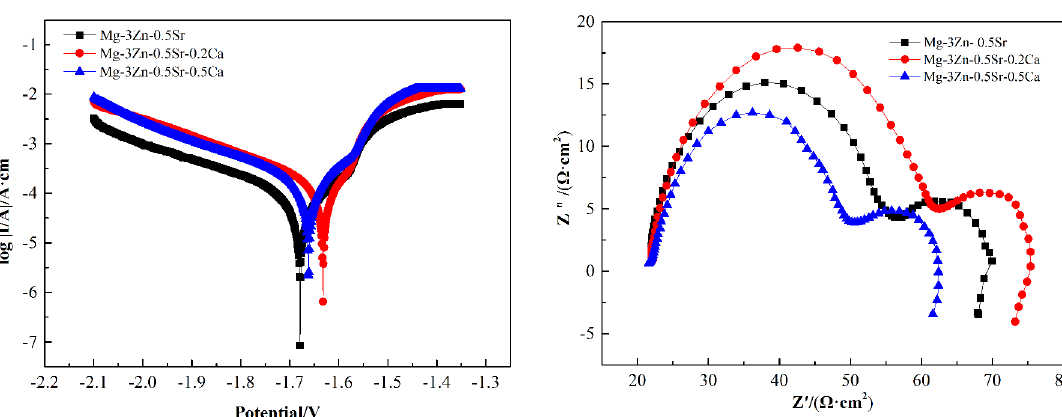
Figure 3. The polarization curves of Mg-3Zn-0.5Sr-xCa alloy samples in the SBF solution